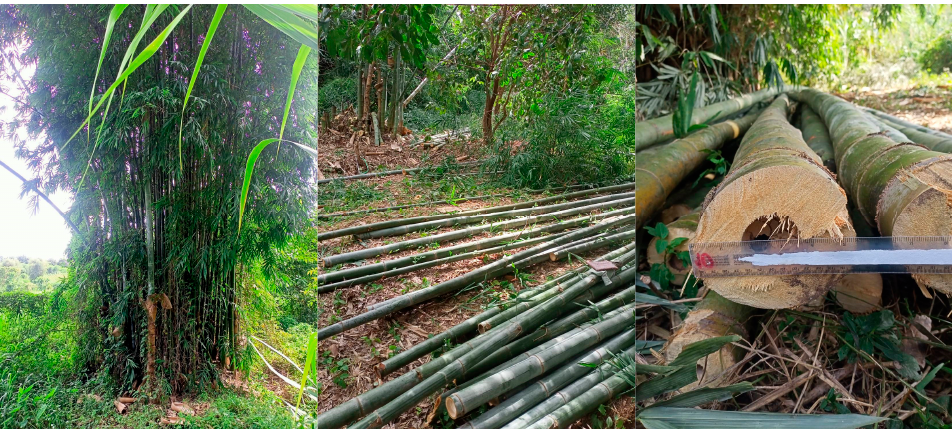
Figure 1. Fresh Dendrocalamus sericeus Munro bamboo.